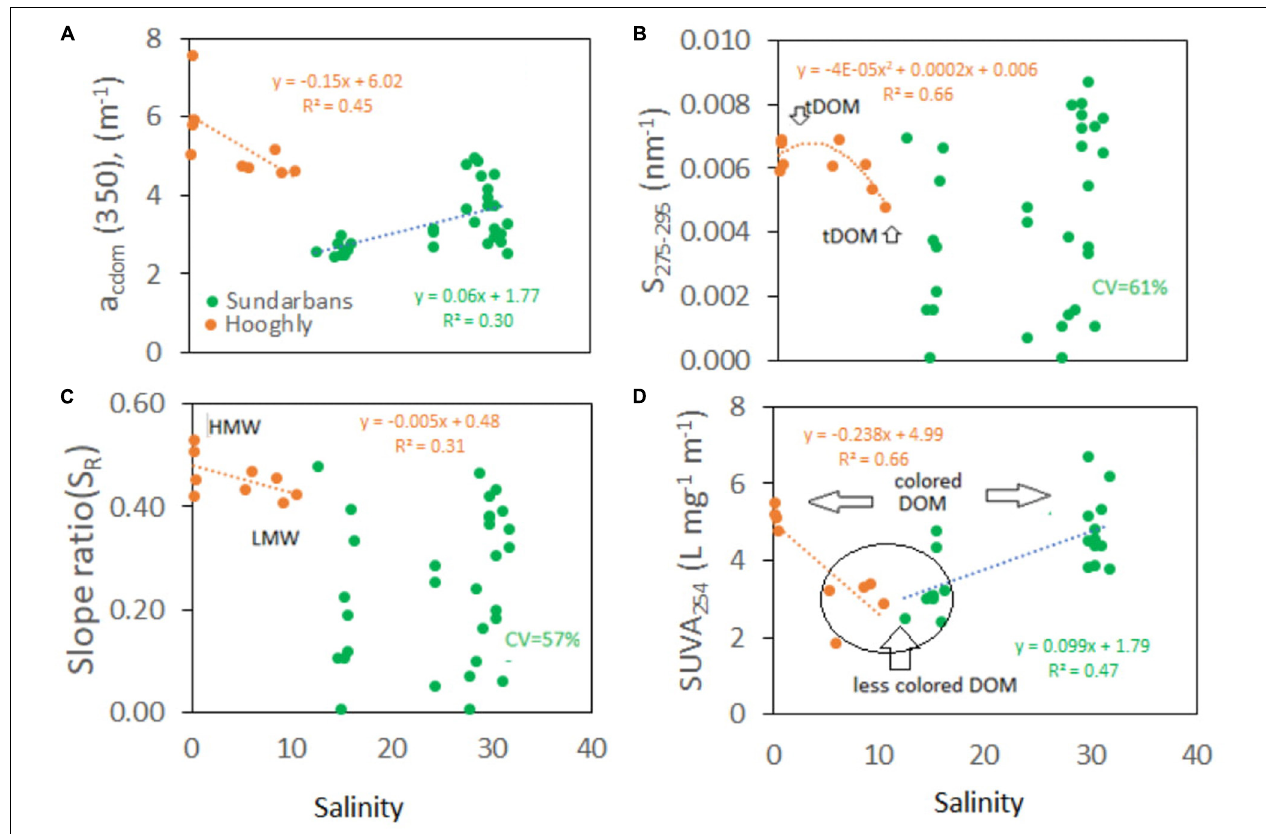
FIGURE 6 | Distribution of (A) a cdom (350) m − 1 , (B) slope at 275 and 295 nm, (C) slope ratio (SR) between 275–295 and 250–400 nm, and (D) SUVA 254 (L mg − 1 m − 1 ). CV: coefficient of variance, HMW: high molecular weight, LMW: low molecular weight, tDOM: terrigenous DOM, SUVA 254 : specific UV absorption at 254